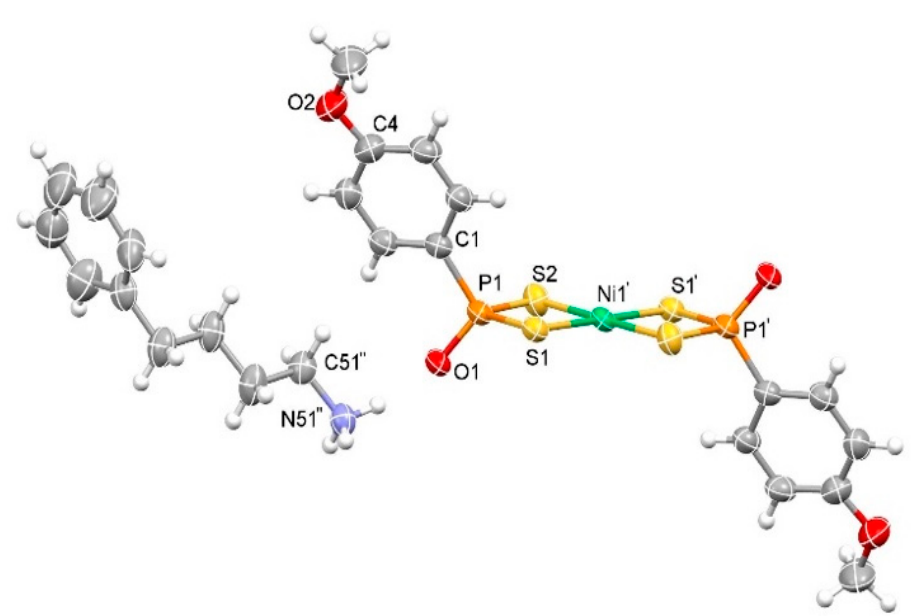
Figure 3. Ellipsoid plot (50% probability level) and numbering scheme for (PhBuNH 3 ) 2 [Ni(dtp) 2 ]. Only one cation is depicted for clarity. Symmetry codes: ' = -x, -y, 1-z; '' = 1-x, 1-y, 1-z.